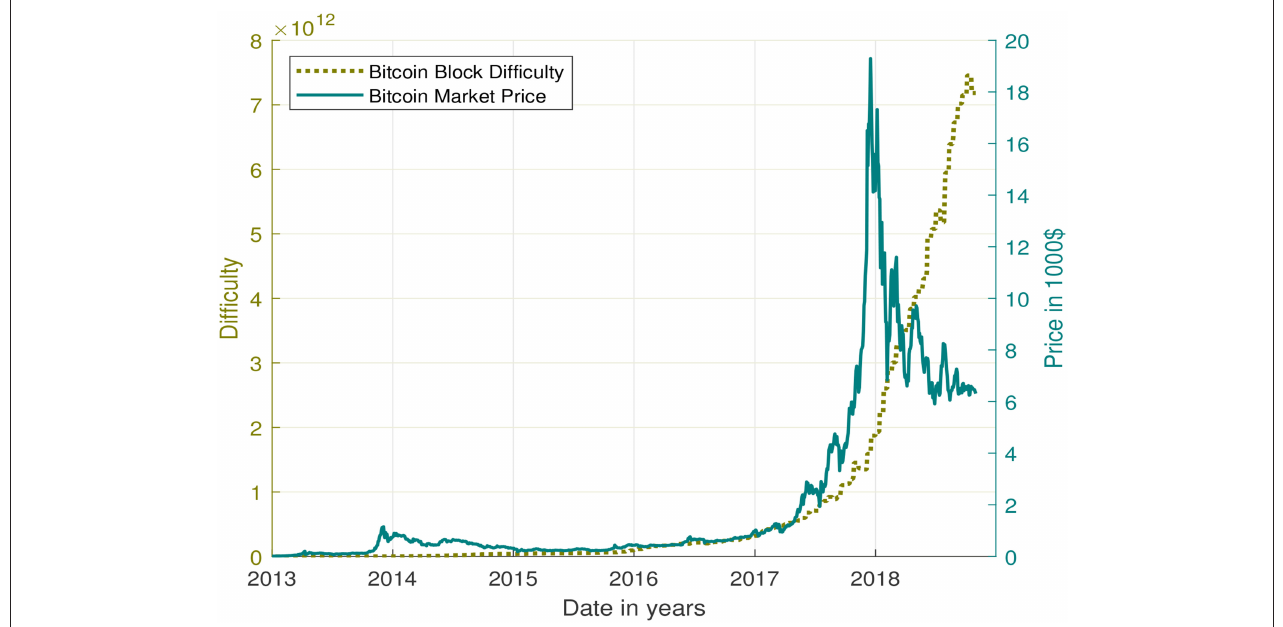
Figure 1 visualizes the development of the Bitcoin block difficulty and the market price from January 2013 to October 2018. Since the beginning of 2014 until October 2018, the with the development of the Bitcoin price until December